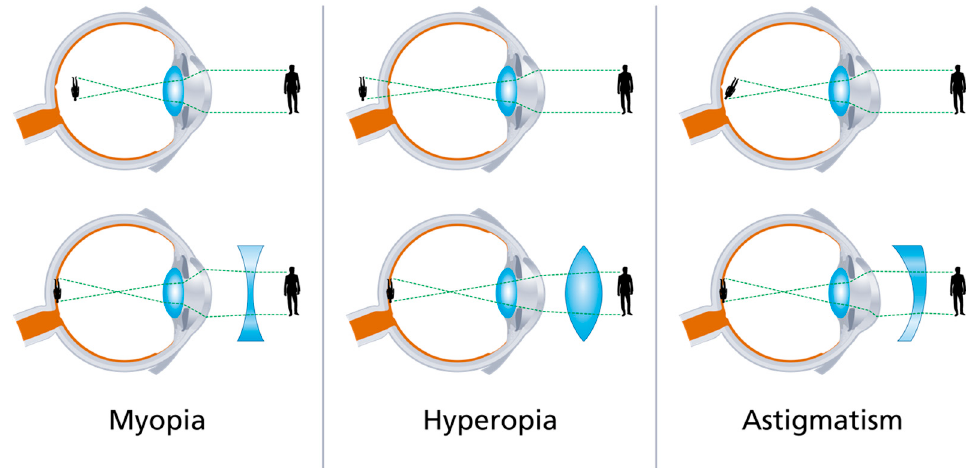
Figure 9. Illustration of different types of refractive error and their correction with lenses. Corneal refractive surgery changes the shape of the cornea according to the corrective lenses.